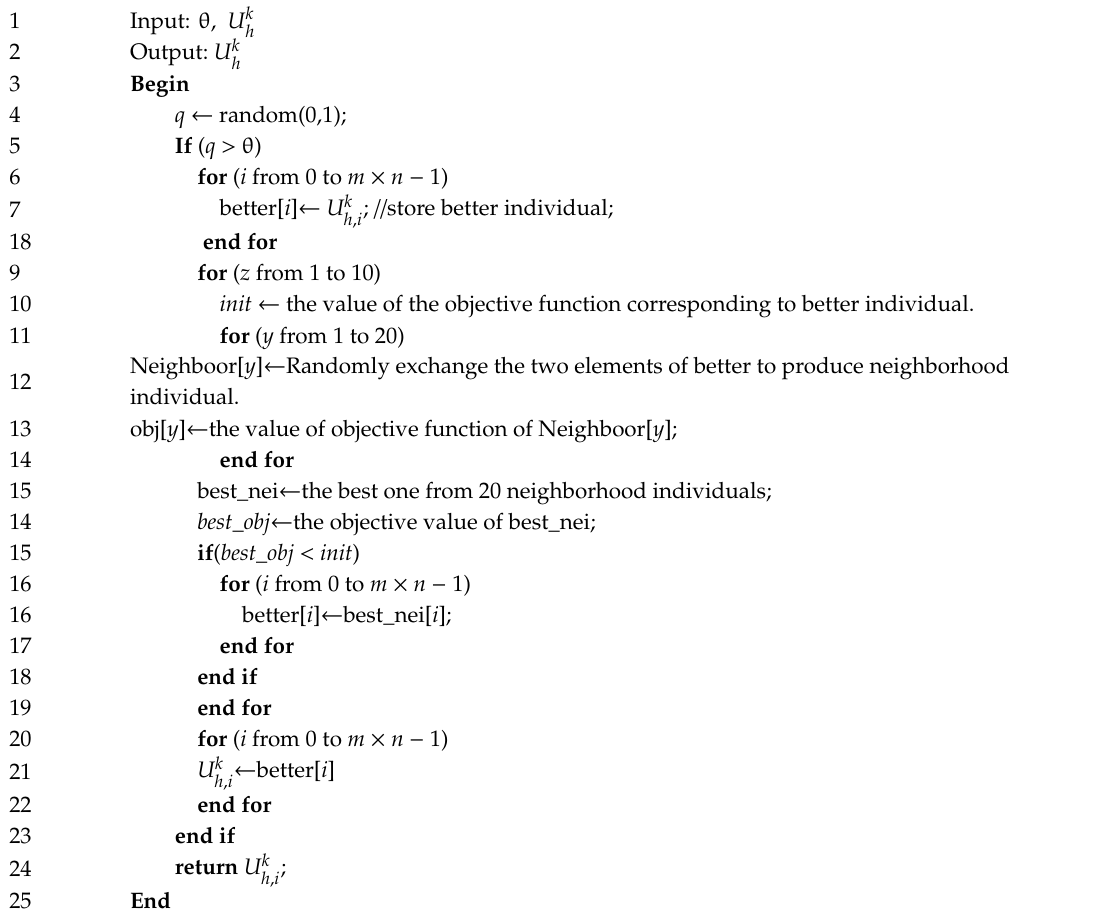
Procedure 4: Hill-climbing-based improvement